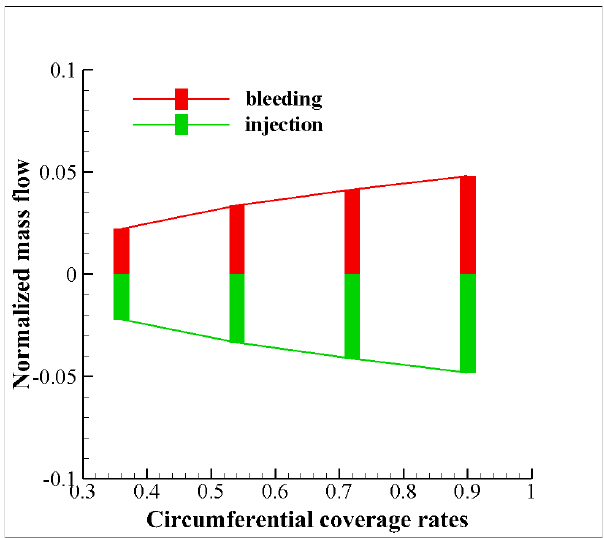
Figure 23. Variation of normalized mass flow level in suction/jet port of the different self-circulating casings.